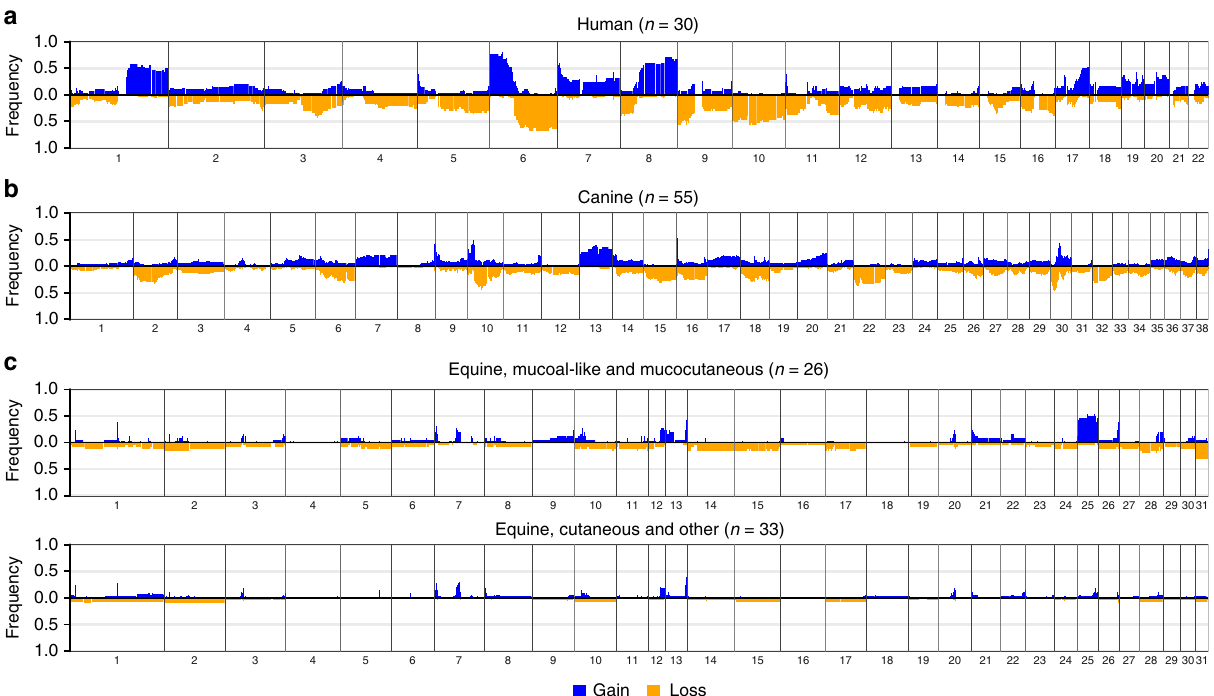
Fig. 3 The DNA copy number alteration landscape of mucosal melanomas from human, canine, and equine patients. Shown are genome-wide frequencies of somatic copy number gains and losses in primary a human mucosal, b canine oral, and c equine melanomas from mucosal-like/mucocutaneous and cutaneous sites in 1 Mb windows. The pattern of genome-wide frequencies of SCNAs in canine and human melanomas was similar to those reported previously. For equine cases, frequent gain of chromosome 25 and loss of chromosome 31 was observed in tumors from mucosal-like or mucocutaneous sites. Included were samples that passed manual quality control (Supplementary Data 4), as described in the Candidate driver genes on these chromosomes include NOTCH1 on chromosome 25 and ARID1B on chromosome 31. For visual comparison of copy number frequency pro fi les relative to